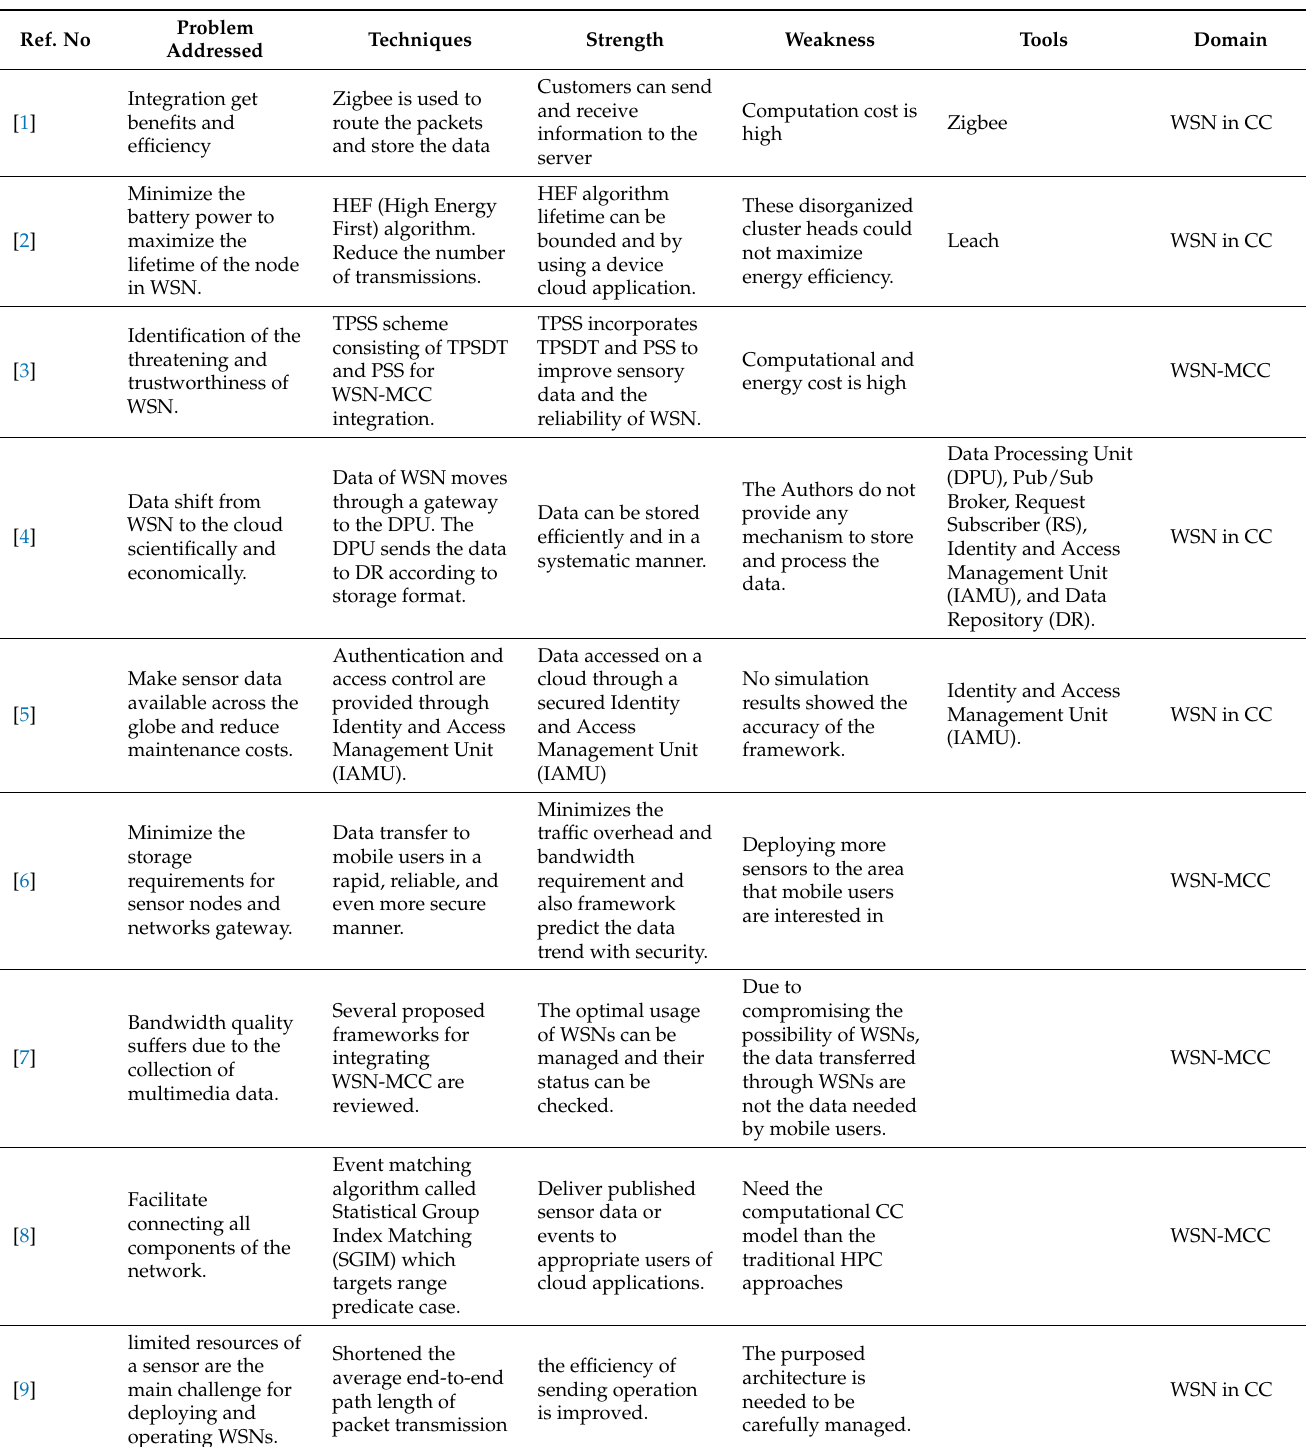
Table 5. Framework comparison of integration of WSN with cloud and